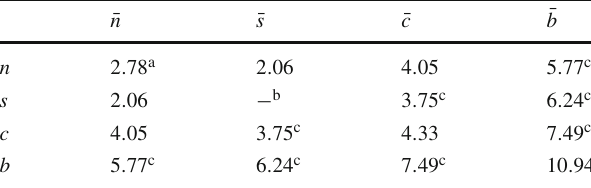
= βπ 2 / 3 . n represents r